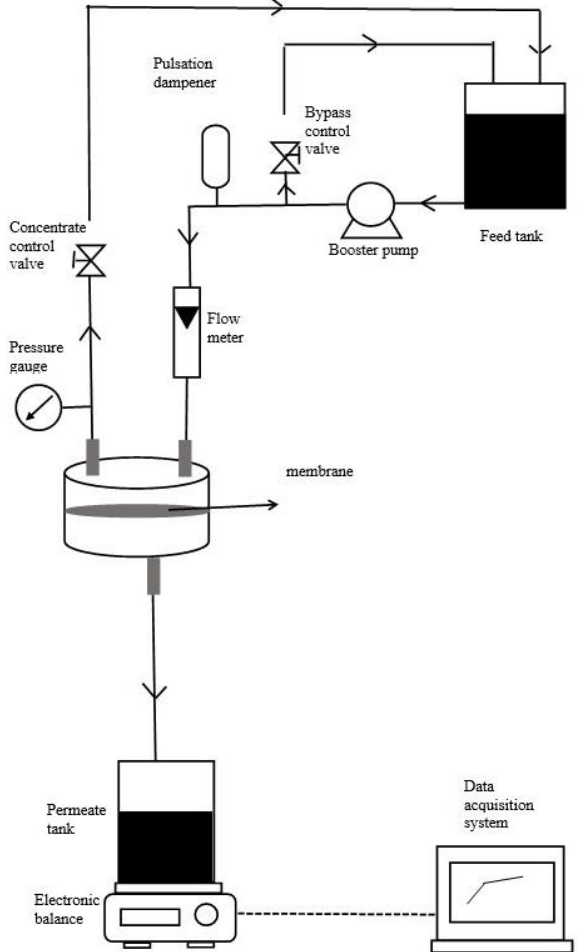
Figure 1. Schematic diagram of a cross-flow filtration system.